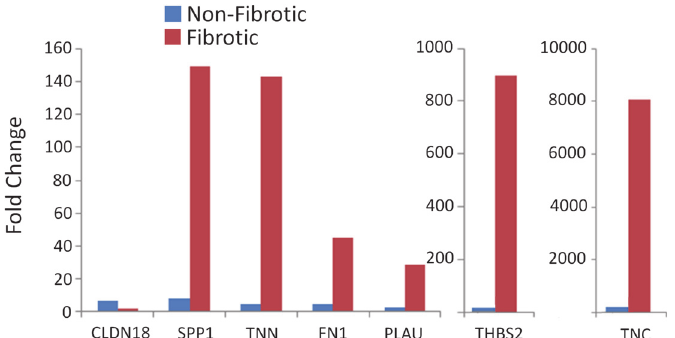
Fig 5. RT-PCR confirmation of microarray data. Confirmation of the microarray results was obtained for a subset of genes by quantitative RT-PCR (qPCR). All changes in gene expression measured by qPCR were in agreement with the changes detected by microarray.